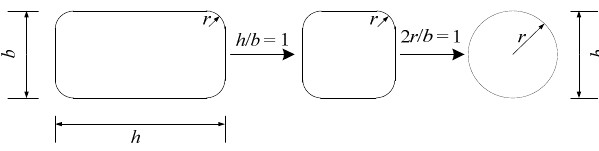
Figure 2. Cross-sectional unification by Wei and Wu [19].